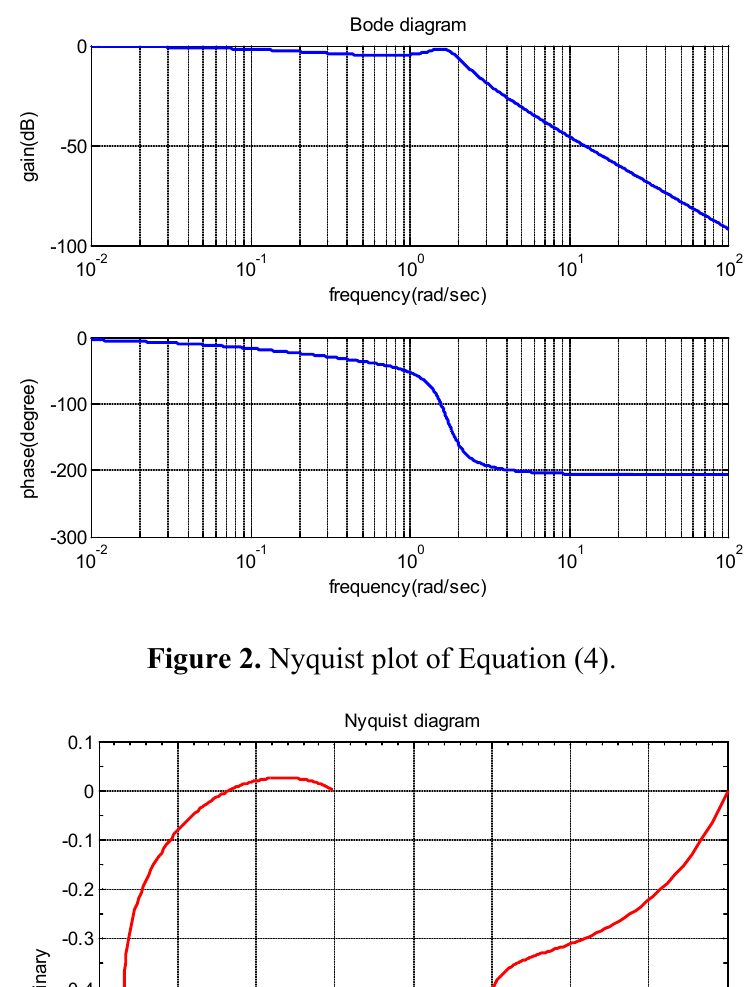
Figure 1. Bode plots of Equation (4).